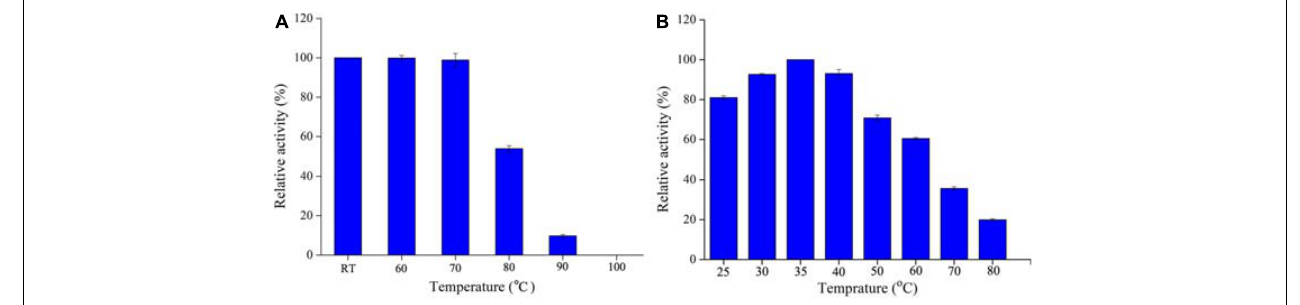
FIGURE 5 | Thermostability (A) and optimal temperature (B) of Aa SOD. For thermostability measurement, the purified Aa SOD was incubated at different temperatures (RT, 60, 70, 80, 90, and 100 ◦ C) for 1 h, and subsequently measured the residual activities. The relative activity was calculated as the percentage of the maximum activity at 35 ◦ C. To achieve the optimal catalytic temperature, the activity of purified Aa SOD was tested at different temperatures (25–80 ◦ C) and the highest activity was set as 100% for relative activity calculation.